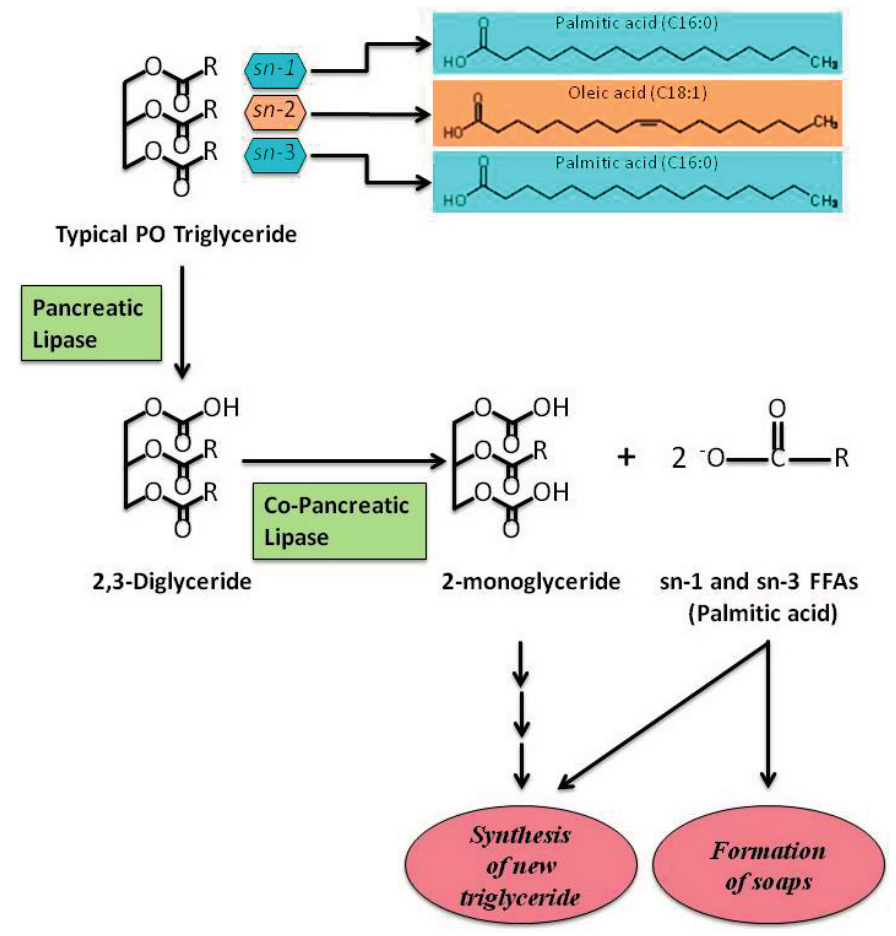
Figure 1. A schematic representation showing the hydrolysis of typical PO triglyceride. Palmitic acid, the main SFA in PO, is situated at SN-1 and SN-3 positions of TAGs.